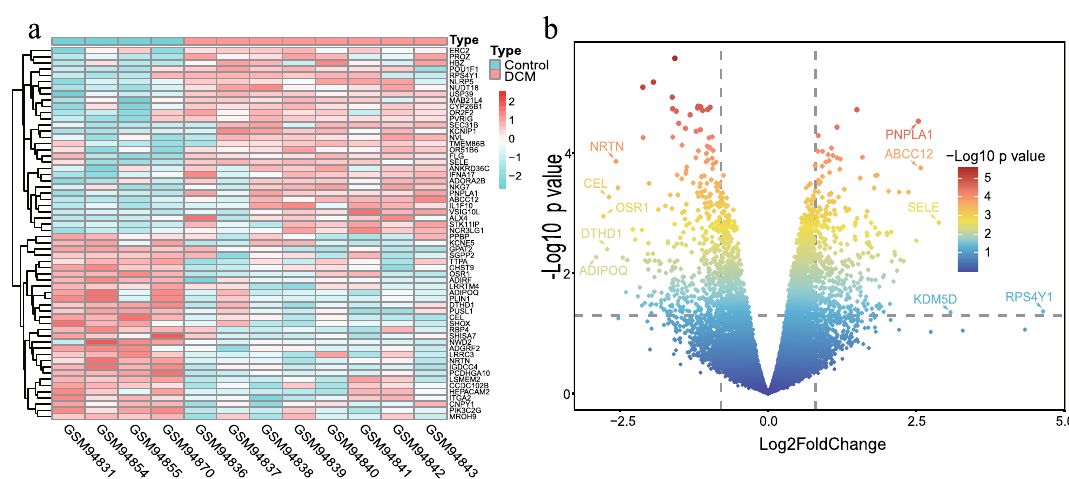
Figure 1. Workflow diagram of the current study. GO, go ontology; TFs, transcription factors.